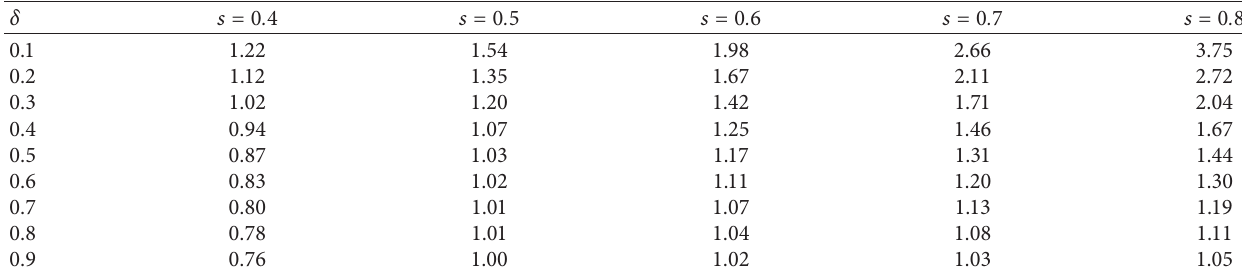
Figure 5: The demand allocation of benchmark (a) and the case with BOPS (b). Table 3: The profit ratio 􏽢 π / π given t � 0 . 6 and θ � 0 .